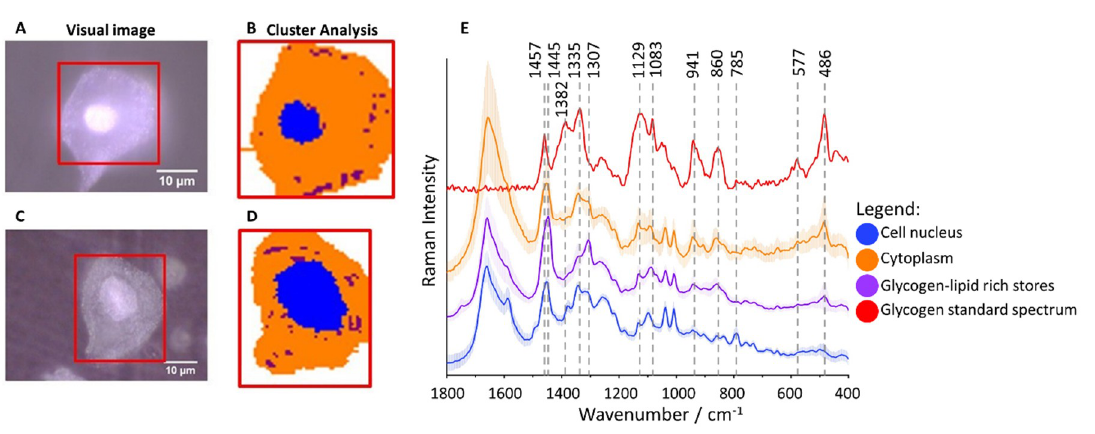
Figure 1. Glycogen-rich cytoplasm and stores in cervical epithelial cells. Microphotographs of representative cells (( A ): IIa / HPV − ; ( C ): IIa / HPV + ) with a cell nucleus of diameter smaller and bigger than 10 µ m, respectively, and CA images ( B , D ) showing distribution of cell nuclei (blue class) and glycogen / lipid-rich stores (maroon class) in the cytoplasm (orange class). The average Raman spectra of cell nuclei, cytoplasm and glycogen / lipid stores ( E ) averaged over all measured cells from all groups (in total 560 cells) along with the spectrum of the glycogen standard.